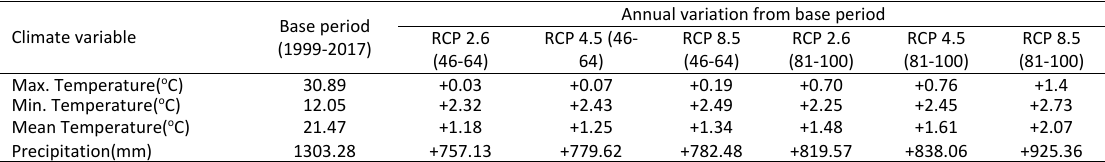
Table 6: Annual variation of climatic parameters